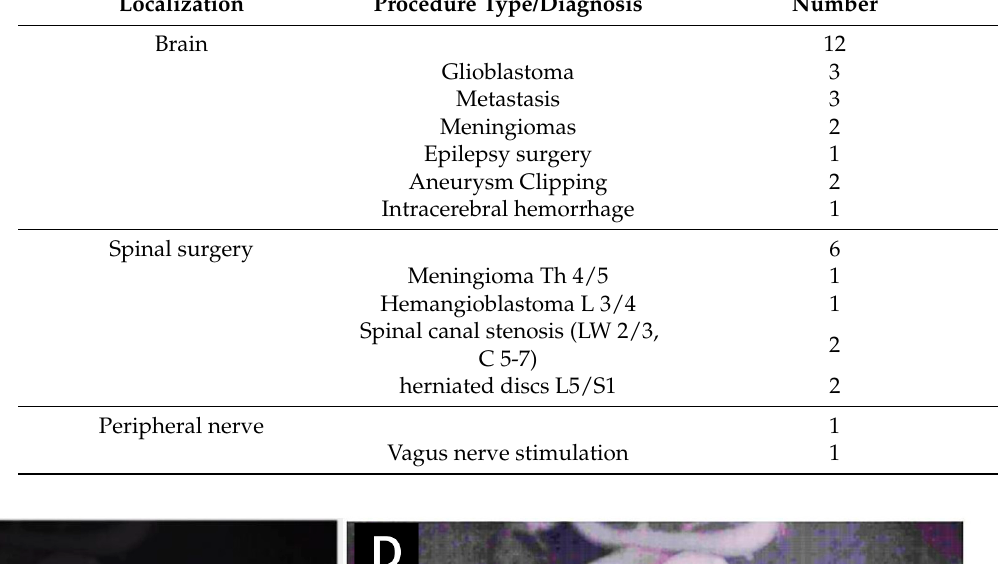
Table 2. Procedures listed by localization, procedure type and diagnosis.